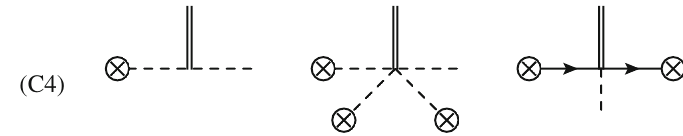
Fig. 16 Various vertices containing one internal graviton line and one internal scalar leg. Here the dashed line is the scalar, the solid line with arrow is the fermion, while the double line depicts the graviton. The lines ending with a circle containing a cross are external